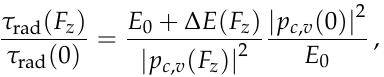
, ( b ) R M , ( c ) R X , h h h